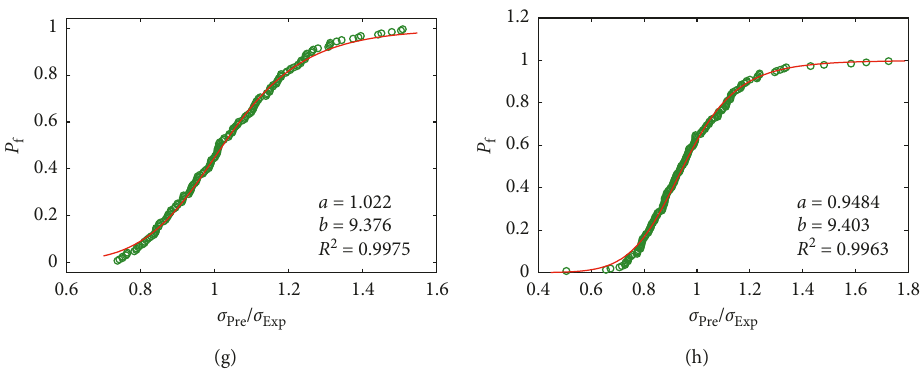
Figure 6: The estimates of the considered estimation methods (the curvilinear lines show the fit of log-logistic distribution): (a) HB-based method, (b) σ u -based method, (c) FPCM-based method, (d) MFPCM-based method, (e) USM-based method, (f) MUSM-based method, (g) MM-based method, and (h) HM-based method.